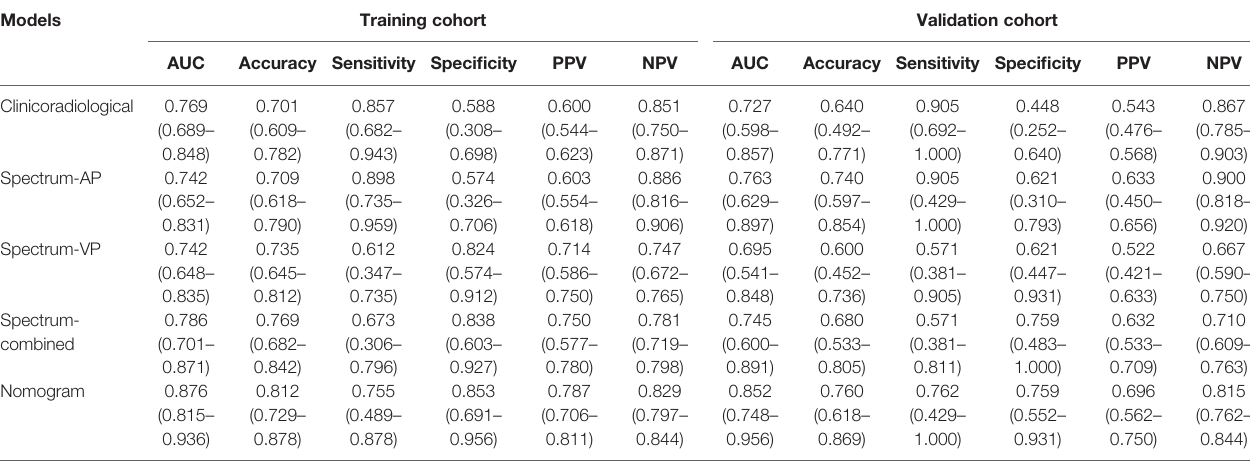
TABLE 2 | Predictive performance of different models in training and validation cohorts. Models